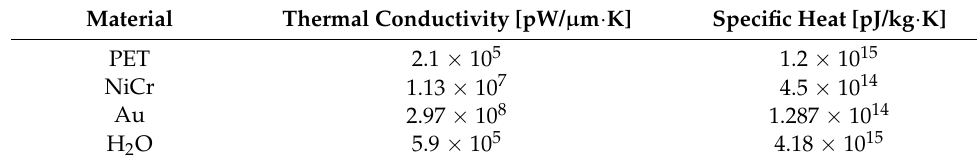
Table 1. Physical properties of the materials.